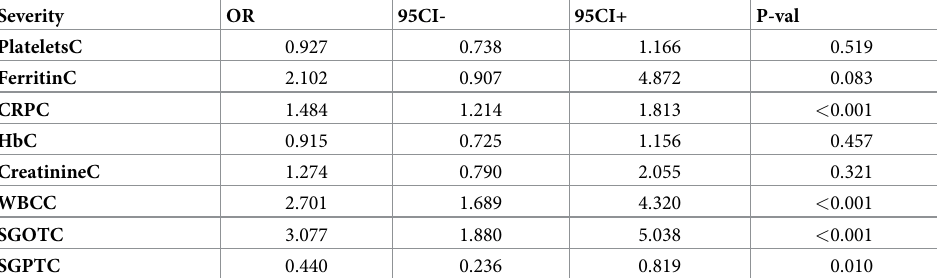
Table 8. Binomial logistic regression coefficients of continuous variables predicting intubation from joint blood panels as exposures. Severity